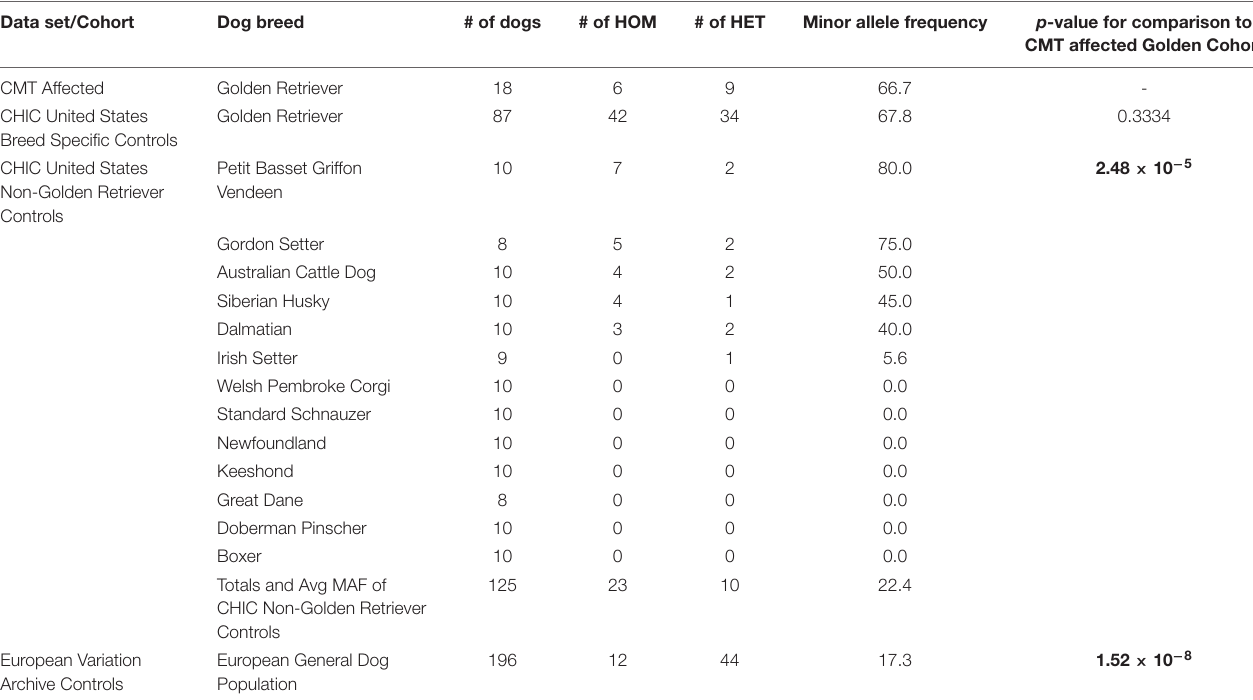
TABLE 1 | CEACAM24 c.247dupG; p.(Val83Glyfs*48) genotypes and allele